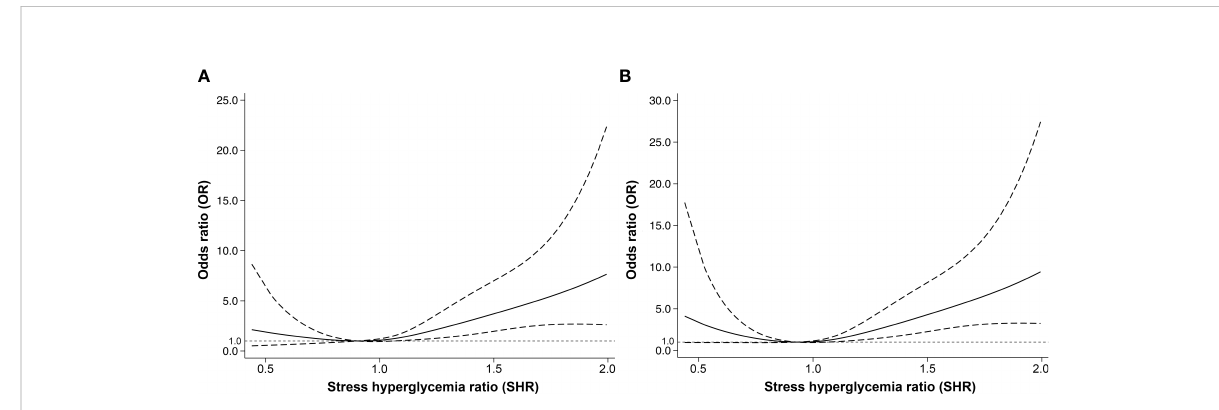
FIGURE 3 The nonlinear relationship between stress hyperglycemia ratio and adjusted odds ratios of poor functional outcomes at (A) 90 days and (B) 1 year. The nonlinear relationship was modeled by restricted cubic splines. The dashed lines indicate the 95% con fi dence intervals of the nonlinear solid